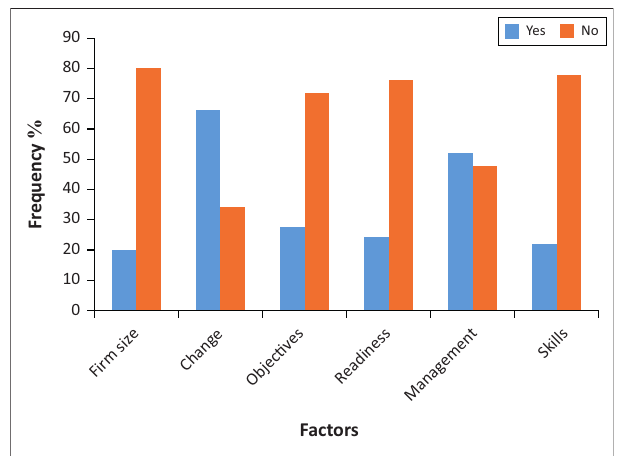
FIGURE 8: Organisational factors.